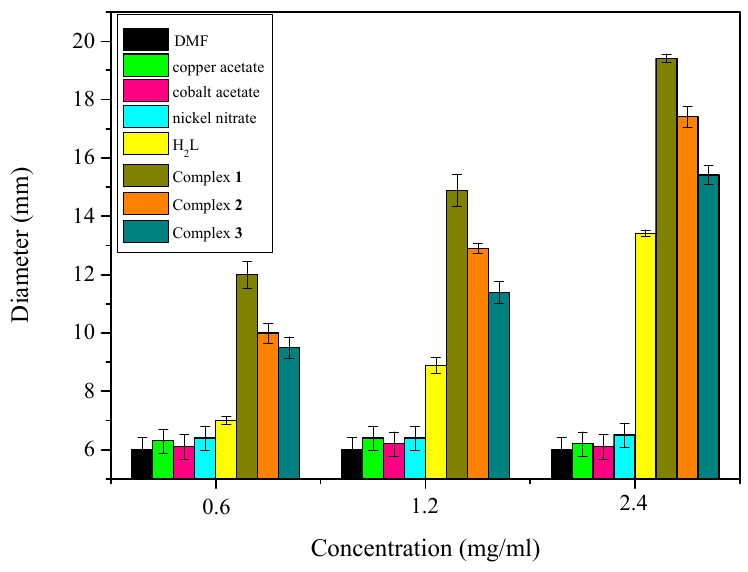
Figure 15. The diameter of inhibition zones of S. aureus in different concentrations.